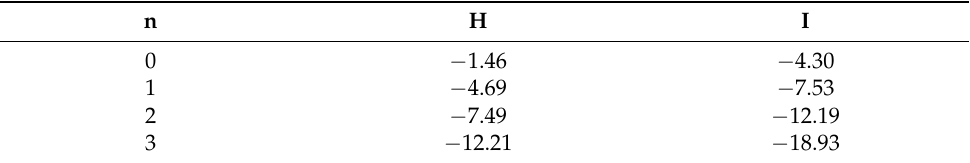
Table 7. BSSE-corrected CCSD(T)//MP2/aug-cc-pVTZ interaction energies, ∆ Es (kcal/mol),